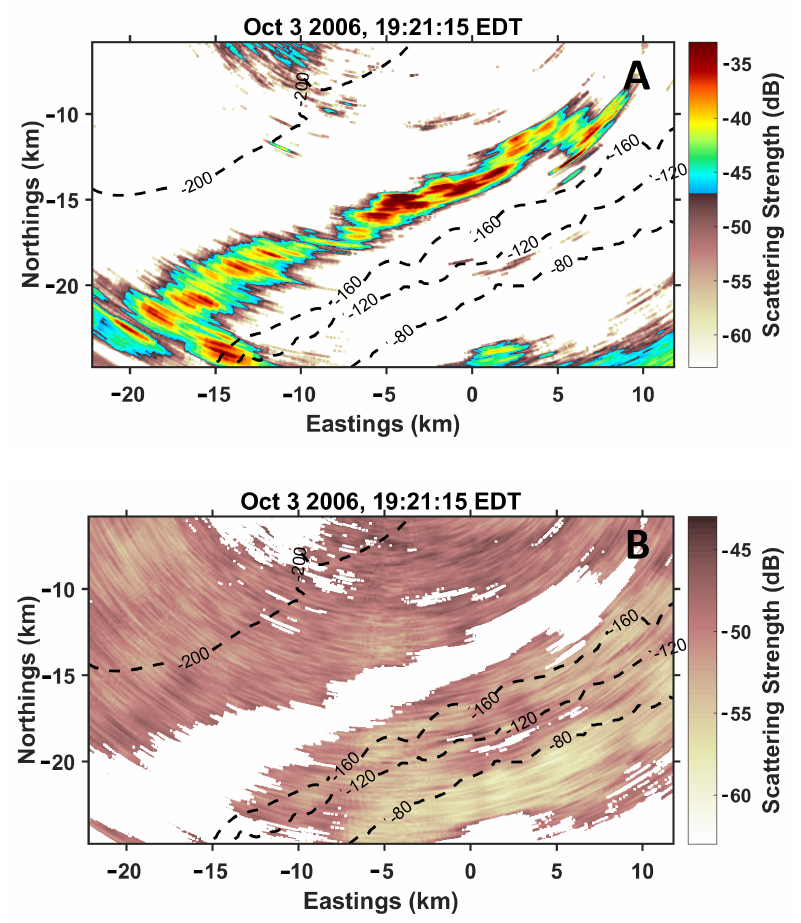
Figure 8. Each pixel in Figure 3B measured on 3 October 19:21:15 EDT is classified as being dominated by fish or seafloor scattering with the log-likelihood ratio test of Equation (3) using relative frequency responses obtained by subtracting the mean instantaneous average scattering strength across fre- quency at each pixel. ( A ) Pixels classified as dominated by fish scattering. ( B ) Pixels classified as dominated by seafloor